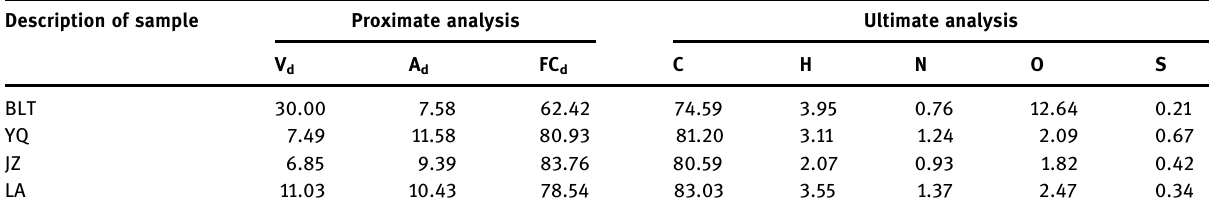
Table 1: Proximate and ultimate analyses of pulverized coal, wt% ( dry basis )